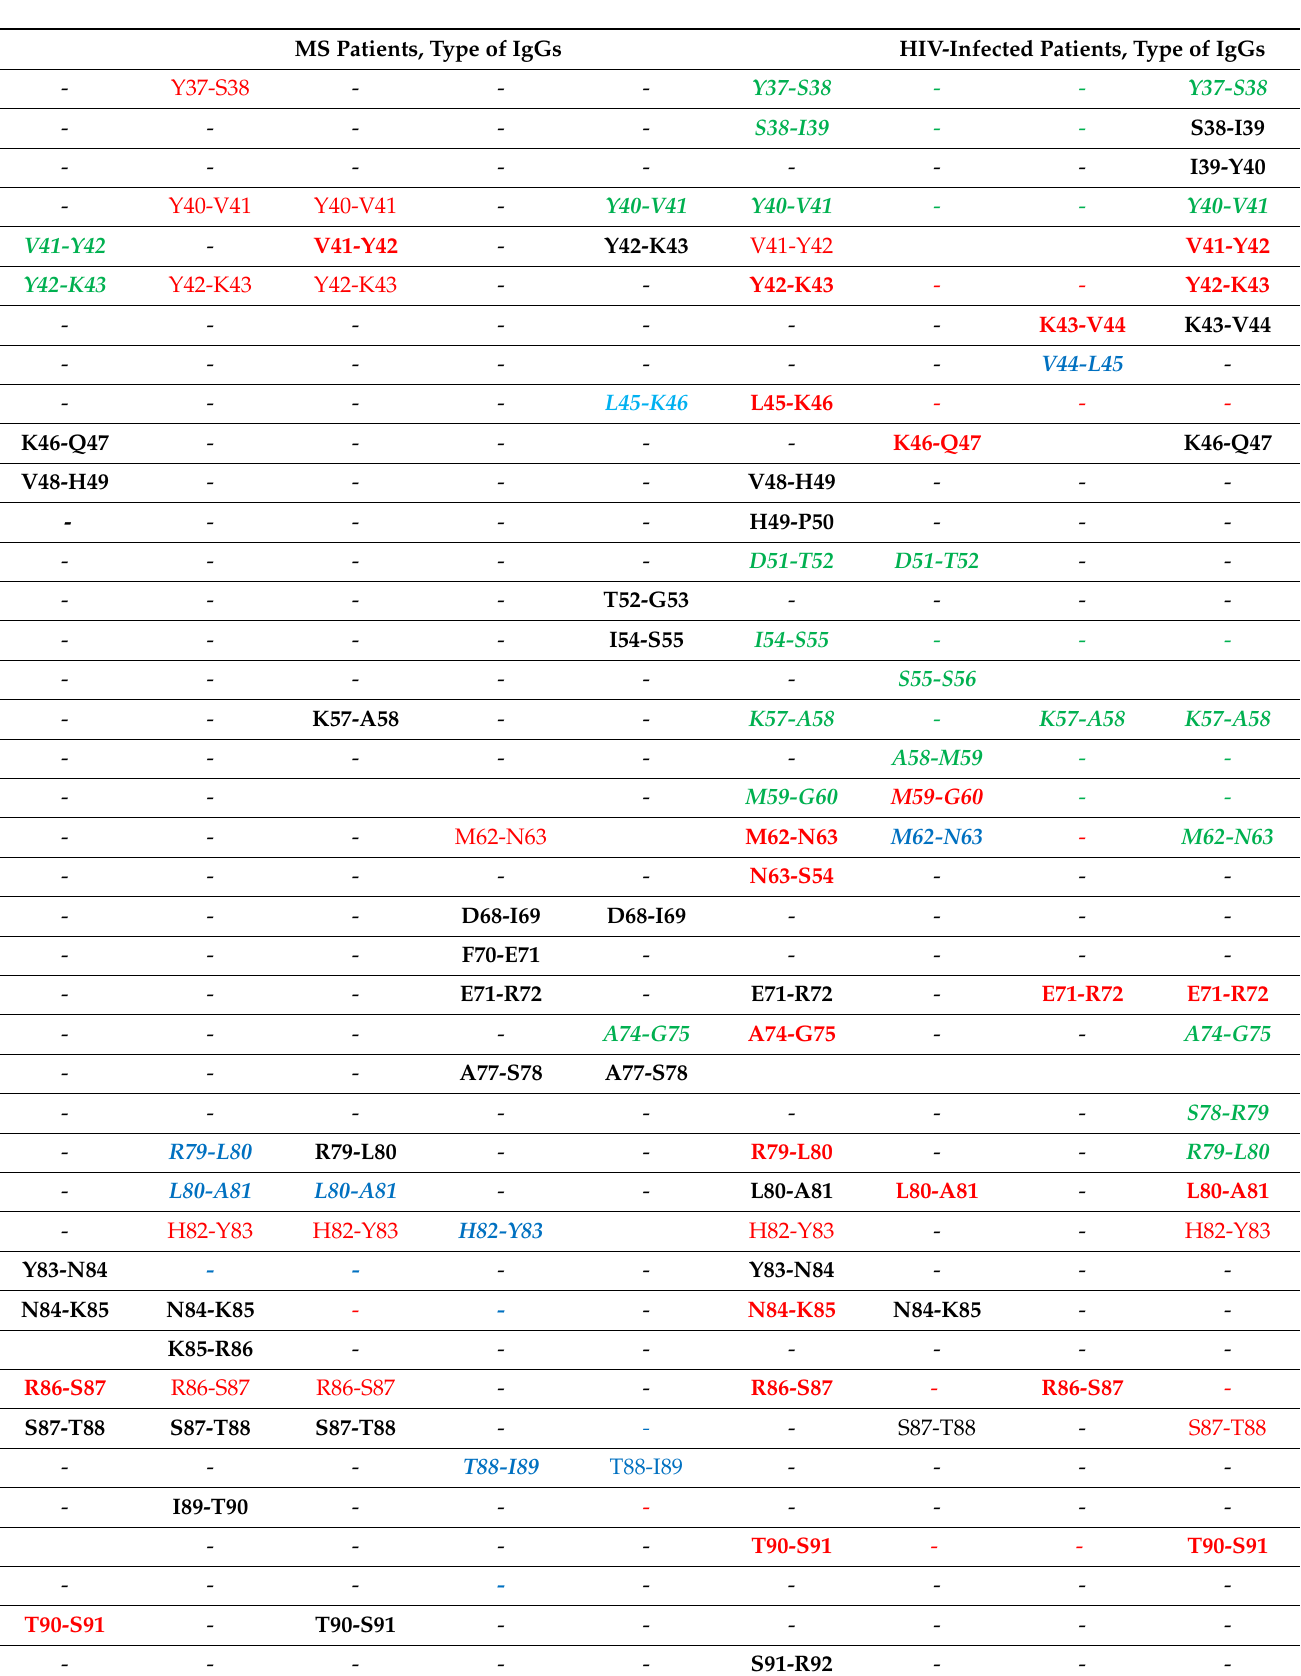
Table 1. Cont. MS Patients, Type of